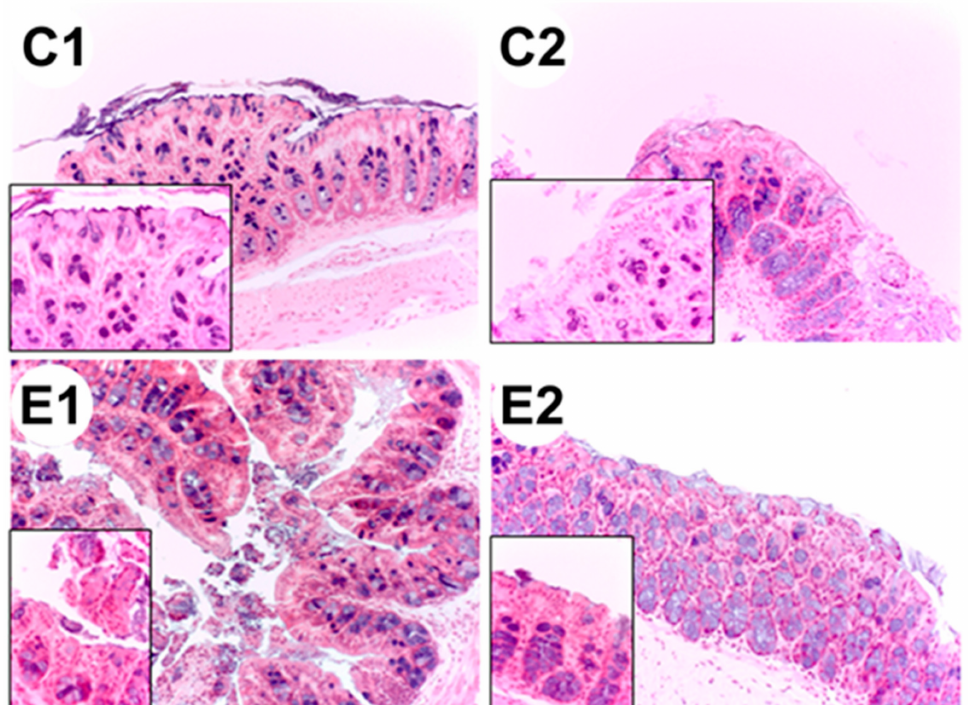
Figure 5. Histological sections of the colon from each experimental group: C1 wild-type mice fed a standard diet, C2 Apc Min/+ fed a standard diet, E1 Apc Min/+ fed a standard diet supplemented with microencapsulated Bf and Lg , E2 Apc Min/+ fed a standard diet supplemented with microencapsulated Bf, Lg, and quercetin. The images were taken at 20 × and at 63 × (left lower panel, increased